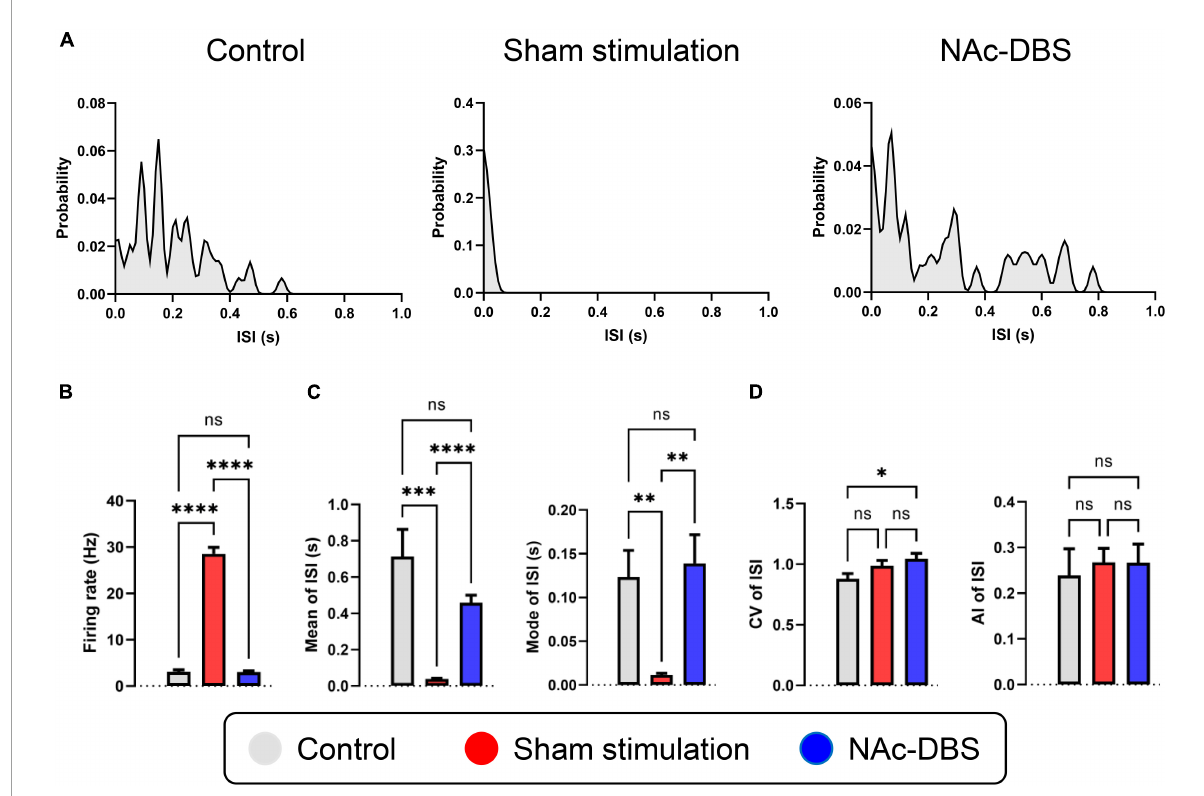
FIGURE4 Alterations in the firing rate and firing patterns of neurons in the NAc. (A) Representative distribution curves of interspike intervals of control, sham stimulation and NAc-DBS groups. (B) The bar graph represents the mean level of firing rates. (C) The bar graphs represent the mean and the mode of ISI. (D) The bar graphs represent the level of CV and AI of ISI. ISI, interspike interval; CV, coefficient of variance; AI, asymmetry index. The data are presented as the mean ± SEM; n = 24 vs. n = 47 vs. n = 48; ∗∗∗∗ P < 0.0001, ∗∗∗ P < 0.001, ∗∗ P < 0.01, ∗ P < 0.05; ns, no significance.